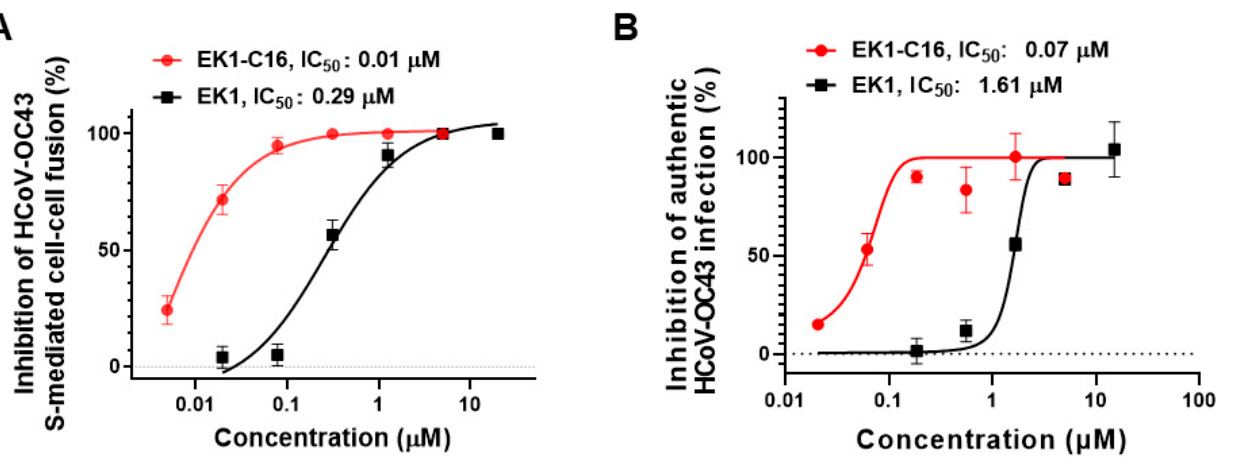
Figure 6. EK1-C16 can broadly inhibit HCoV-OC43 infections. ( A ) Inhibitory activity of EK1-C16 against HCoV-OC43 S-mediated cell–cell fusion. ( B ) Inhibitory activity of EK1-C16 against authentic HCoV-OC43 infection. The samples were tested in triplicate and the experiment was repeated once.